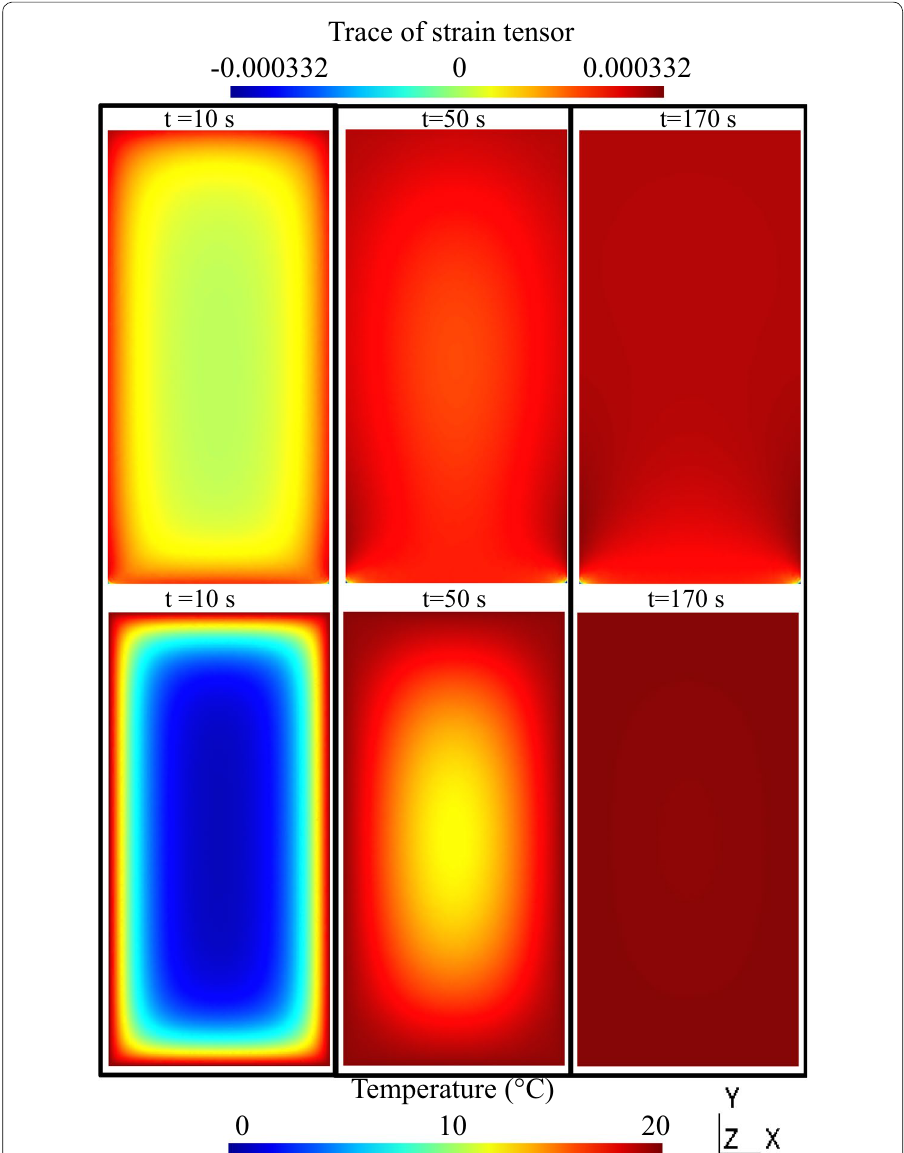
Fig. 6 Volumetric strain is estimated from the trace of the strain tensor and is mapped (top) at distinctive moments of a loading step of the simulation when temperature increases by 10 °C at the boundaries (time in seconds). For each map of volumetric deformation, we show the corresponding temperature field